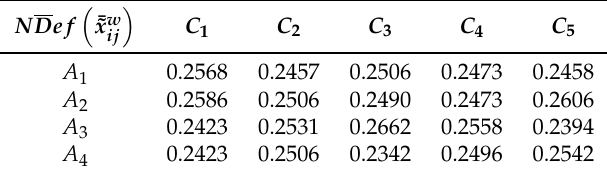
Table 7. The negation weighted decision matrix NDef ( ¯˜ D ) .